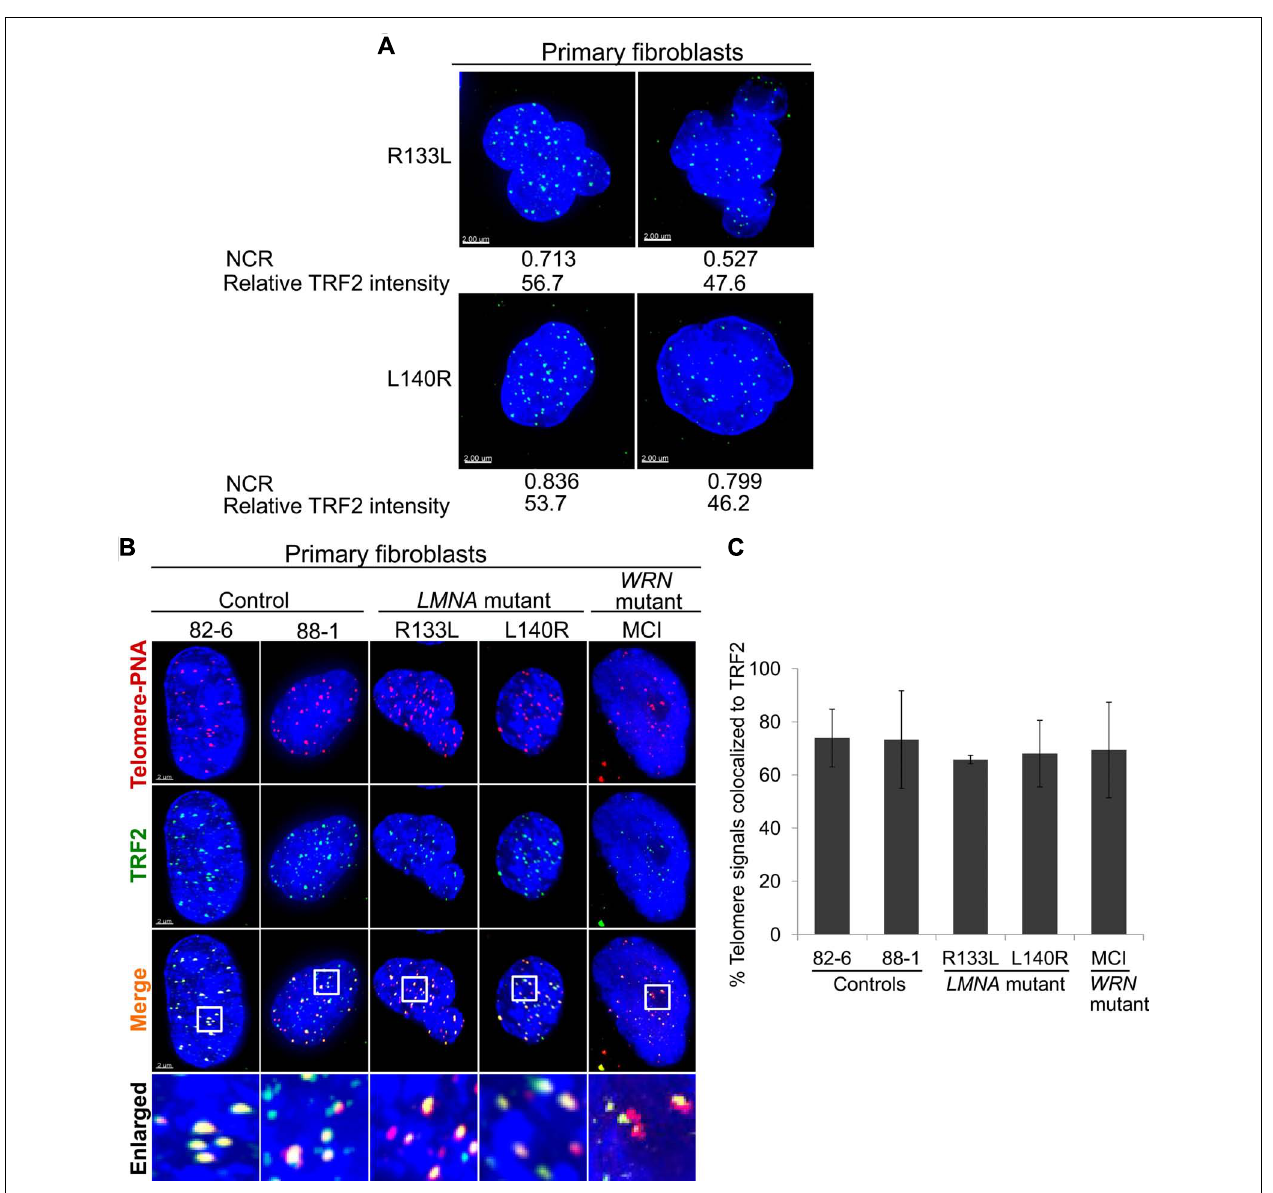
FIGURE 2 | Intranuclear localization ofTRF2 in primary fibroblasts. (A) Abnormal nuclear morphology as measured via NCR andTRF2 expression (green) in LMNA mutant cells. (B) Immuno-FISH staining of telomeres (using a telomeric PNA probe; red),TRF2 (green) and DNA (using DAPI; blue)